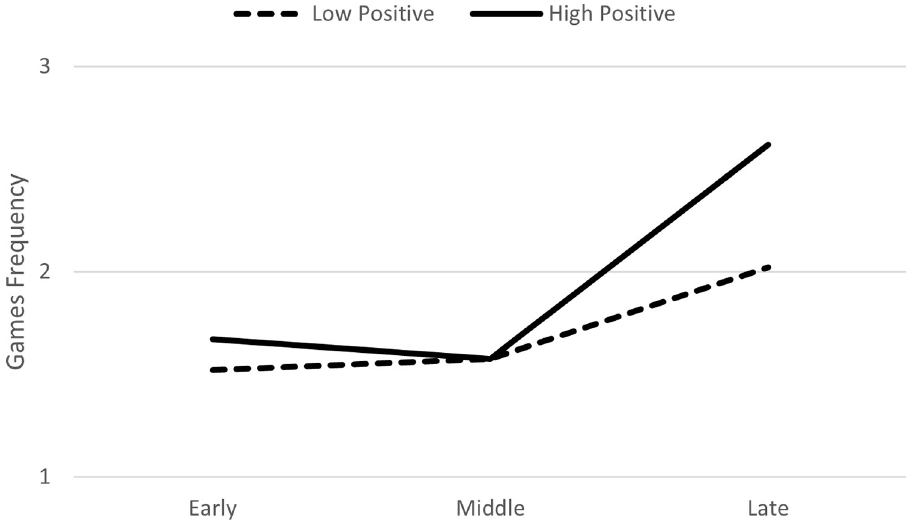
Fig 1. Change over time in frequency of games as function of positive actions in the first phase of the relationship.